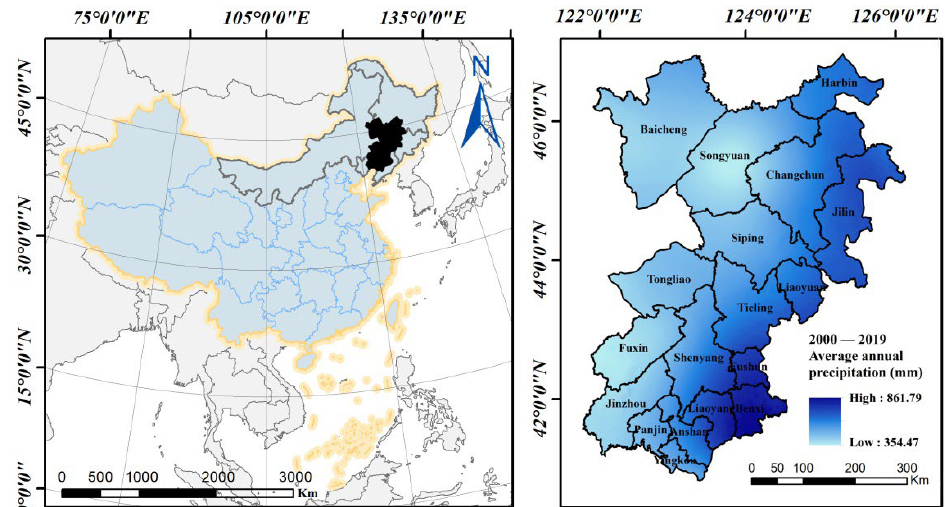
Figure 2. Location of the study area.